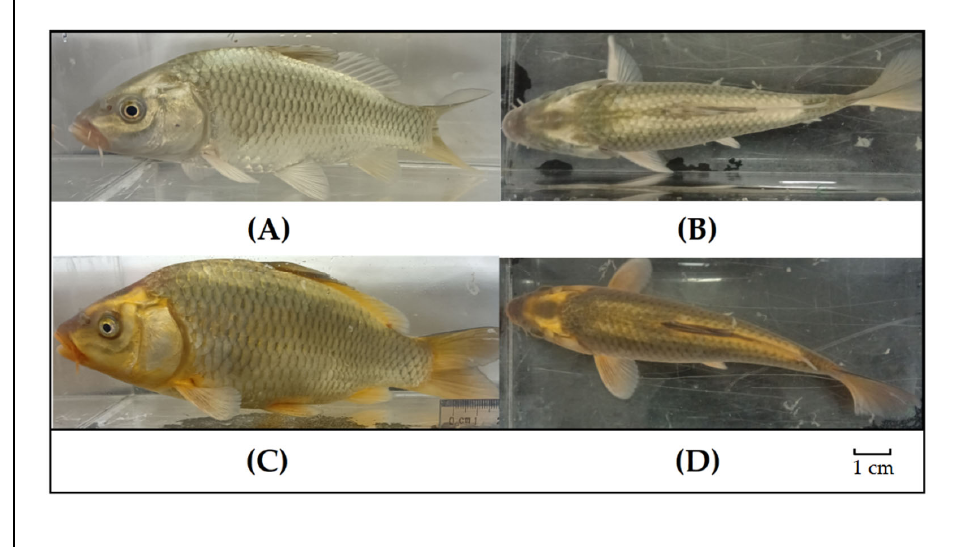
Figure 1. ( A , B ) Front and side photos of the LP, HP, JP and CJ populations of the golden ‐ backed carp; ( C , D ) front and side photos of the DY population of the golden ‐ backed carp.